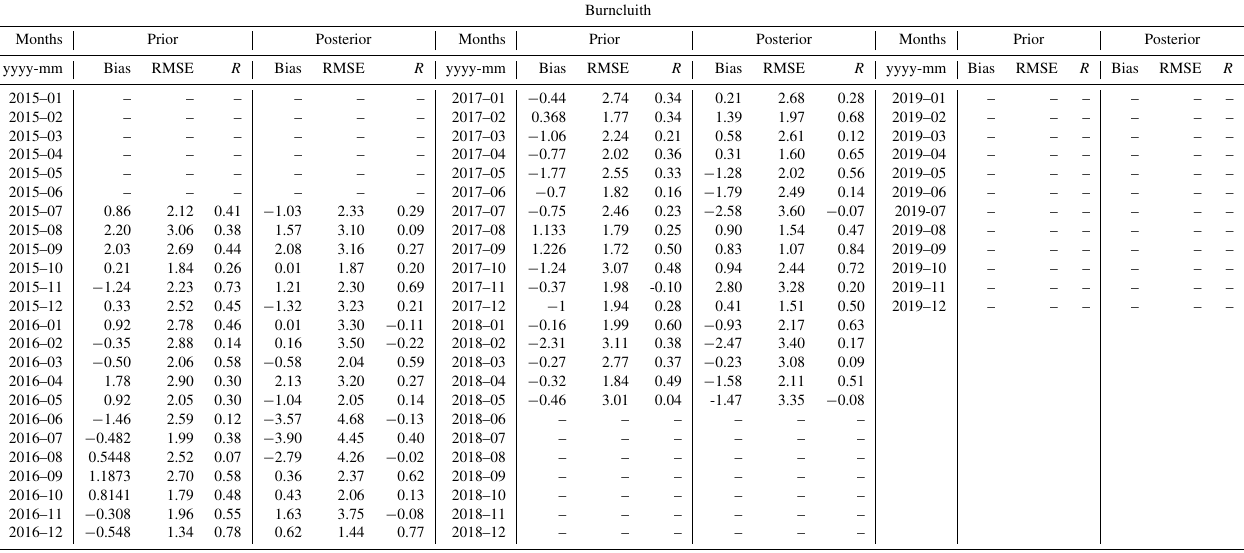
Table G4. Analysis of the residual between CMAQ prior and posterior simulation values and the Burncluith site for the 2015–2019 period, showing the averaged bias (Bias), root-mean-square error (RMSE), and Pearson coefficient ( R ).